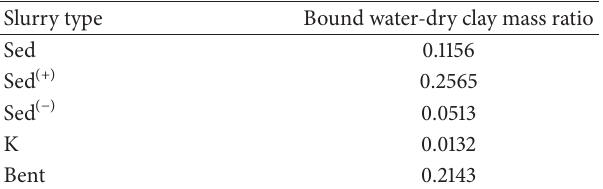
Figure 5: Sectioning of fluid type by the ratio of plastic viscosities in the improved bilinear fluid model. Table 4: Adsorption water-dry clay mass